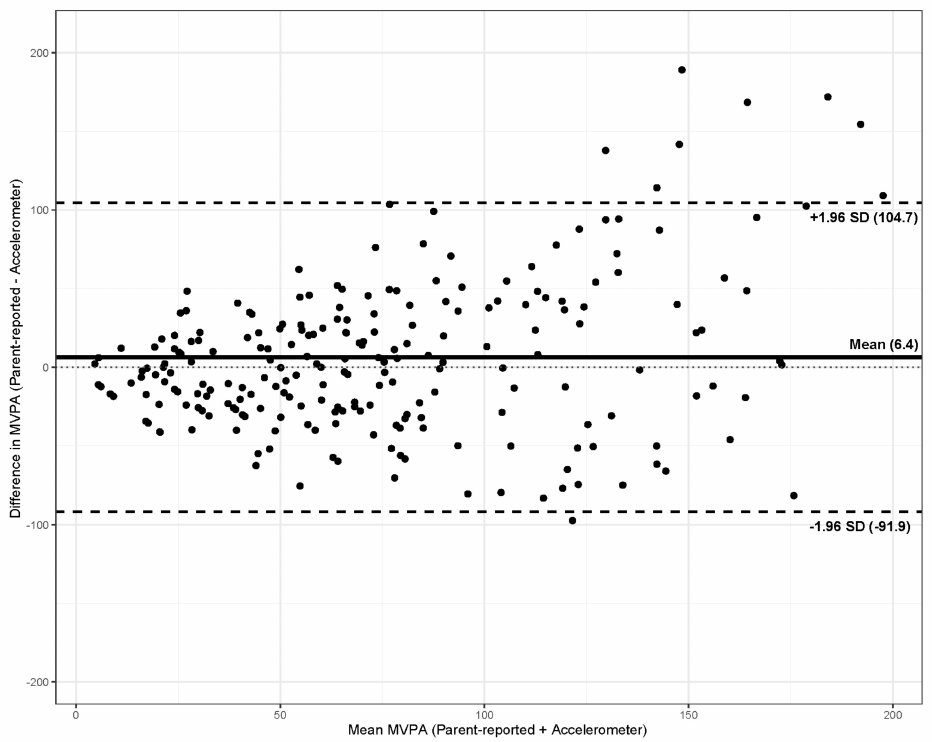
Figure 1. Bland–Altman plot with mean bias (solid line) and 95% limits of agreement (dashed lines) between the children’s parent-reported and accelerometer measurements of moderate-to-vigorous physical activity (MVPA, min/day).